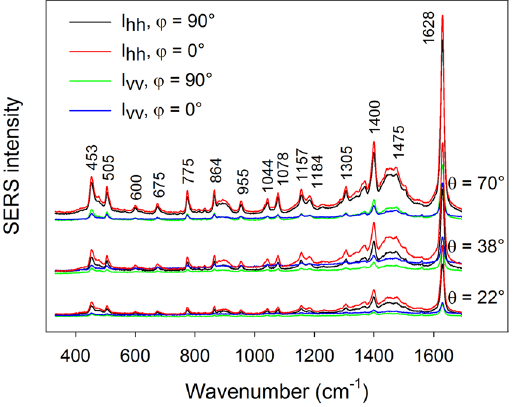
Figure 3. Examples of MB SERS spectra obtained under different configurations. Spectra for different angles θ are offset for clarity.